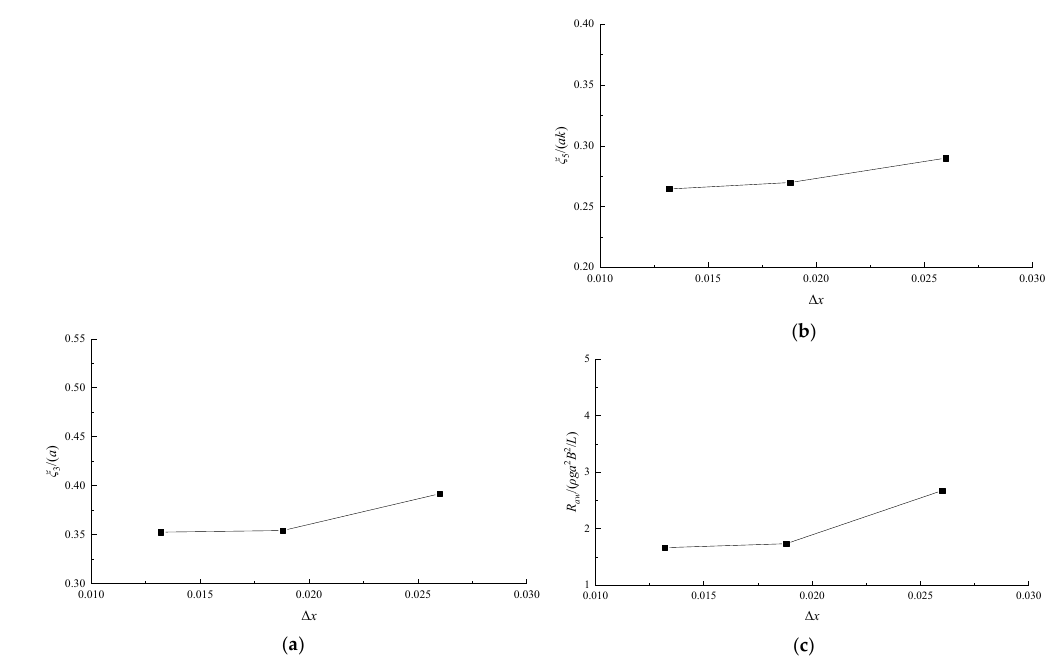
Figure 6. Grid convergence tests. ( a ) heave, ( b ) pitch and ( c ) added resistance. Table 7. Results of error and uncertainty analysis.